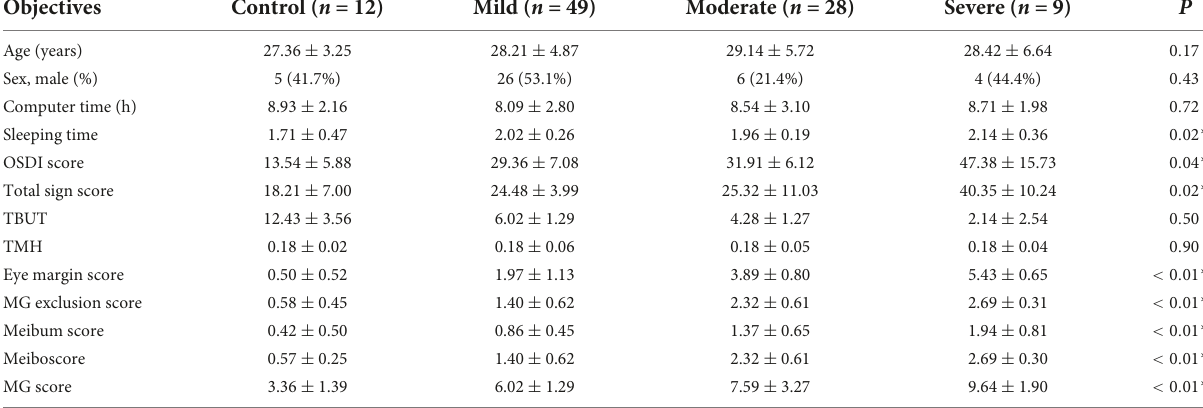
TABLE 1 Basic characteristics of MGD patients and